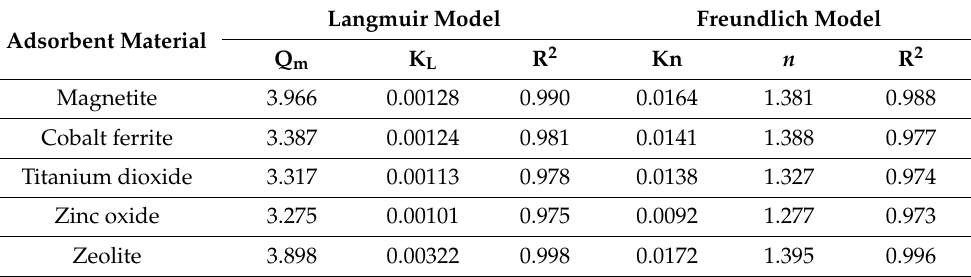
Table 2. The adsorbents Langmuir and Freundlich isotherm